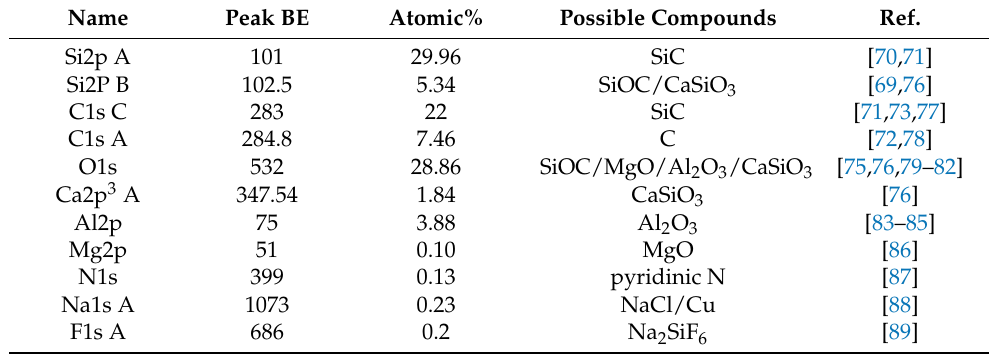
Table 3. Typical photoelectron binding energies of heat-treated sample at 1500 °C for 2 h.